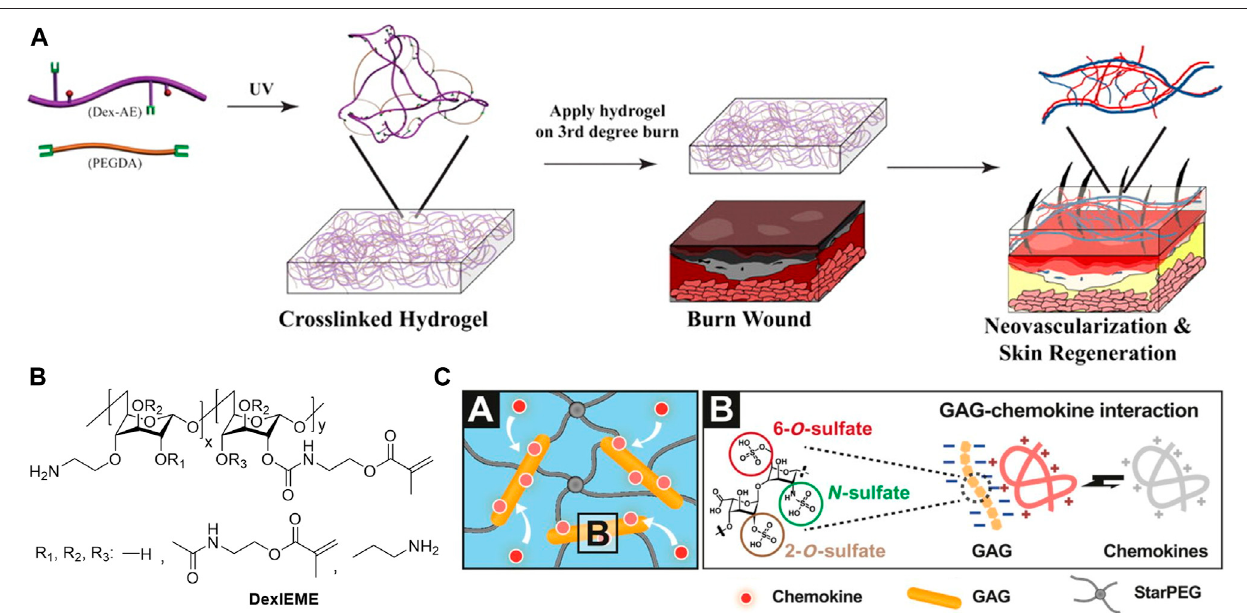
FIGURE 6 | (A) Dextran-allyl isocyanate-ethylamine (Dex-AE)/polyethylene glycol diacrylate (PEGDA) hydrogel promotes neovascularization: Precise structure manipulationresultsinrapid,ef fi cient,andfunctionalneovascularization(Sunetal.,2011).Imageswereadapted withpermissionfromSunet al.(2011).Copyright2011, National Academy of Sciences. (B) Chemical structure of self-crosslinkable dextran-isocyanatoethyl methacrylate-ethylamine (DexIEME) (Sun, 2017). Images were adapted with permission from Sun (2017). Copyright 2017, John Wiley and Sons. (C) Chemokine sequestration by the starPEG-heparin hydrogel networks (depicted in A) through strong electrostatic interactions of heparin derivatives and chemokines (depicted in B) results in a reduced immune cell invasion, which in turn, lowers the concentrations of in fl ammatory chemokines and ultimately allows the in fl ammation to subside (Lohmann et al., 2017). Images were adapted with permission from Lohmann et al. (2017). Copyright 2017, The American Association for the Advancement of